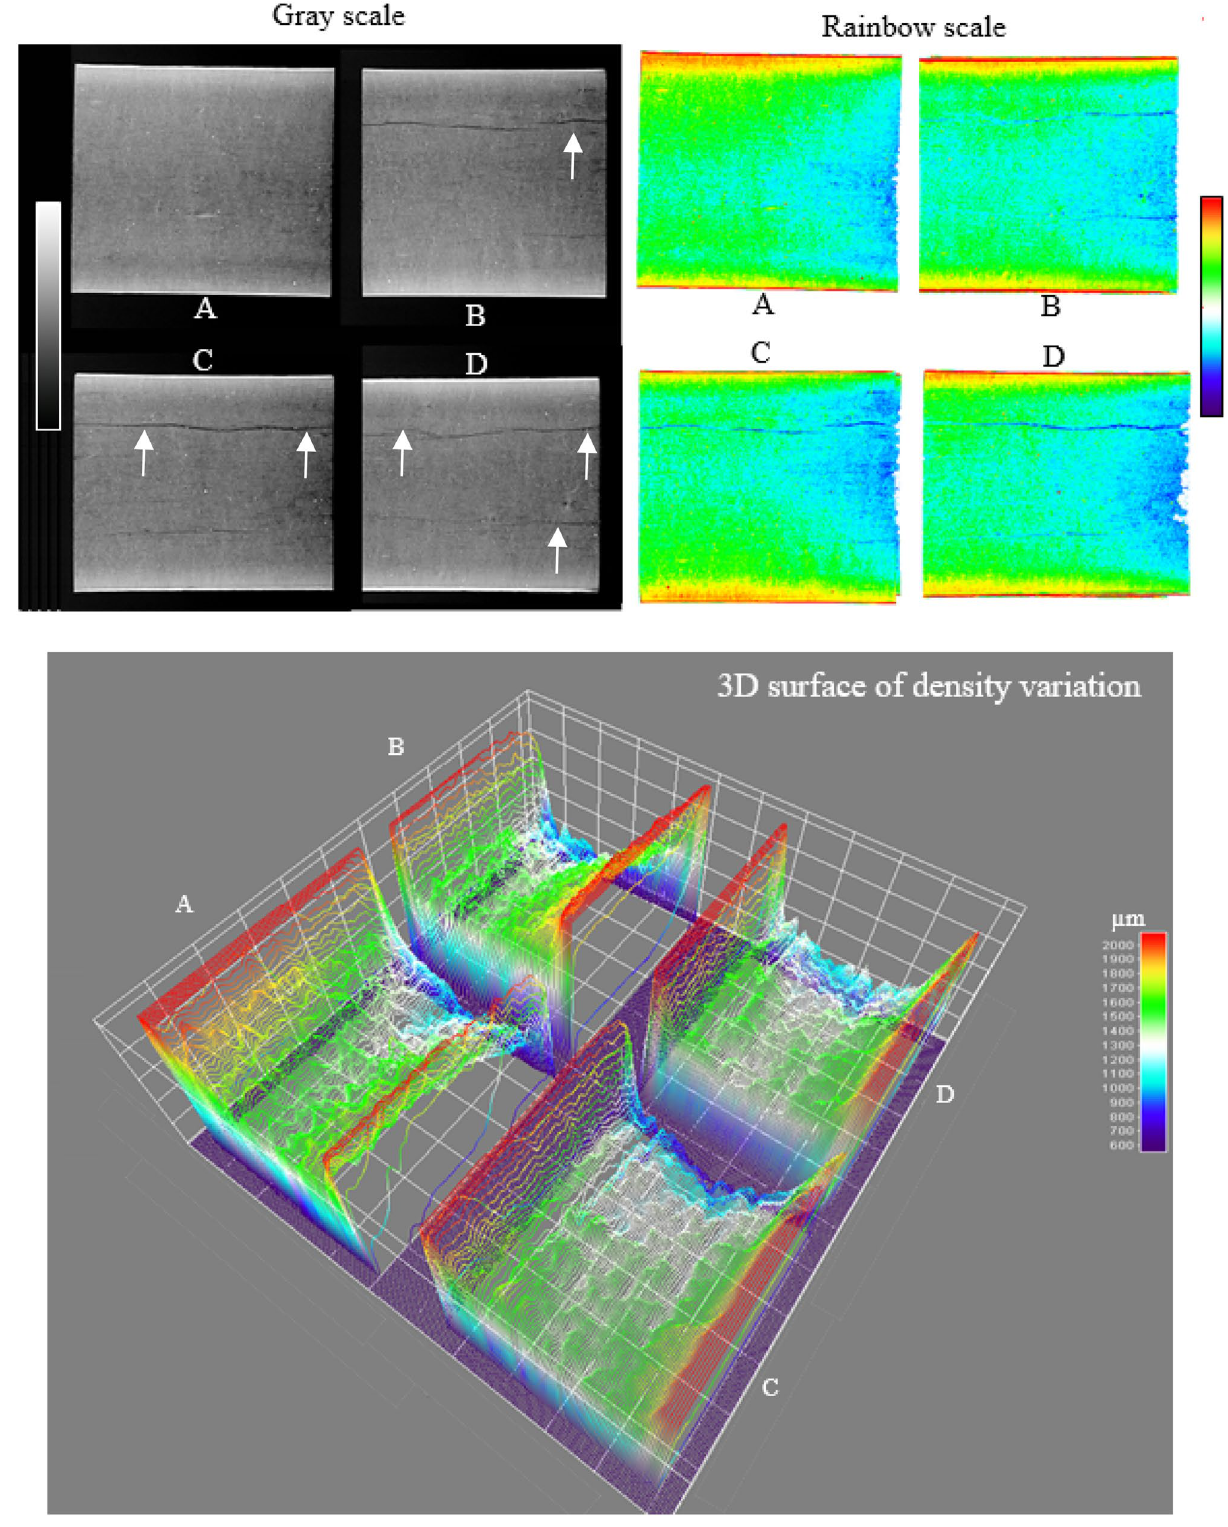
Figure 2. Digital X-ray images of MDF coated residues in gray and rainbow scales and 3D density variation plot. Untreated ( A ); torrefaction for 20 ( B ), 30 ( C ) and 40 ( D ) minutes. Areas with red and blue color indicate higher and lower density, respectively. White arrows indicate the